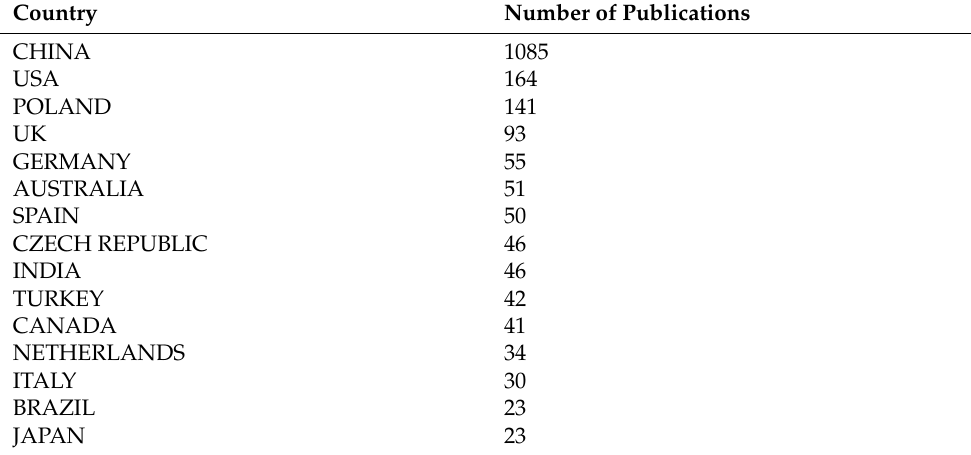
Table 2. Top 15 countries publishing articles in the field of land consolidation and rural revitalization from 1950 to 2021.